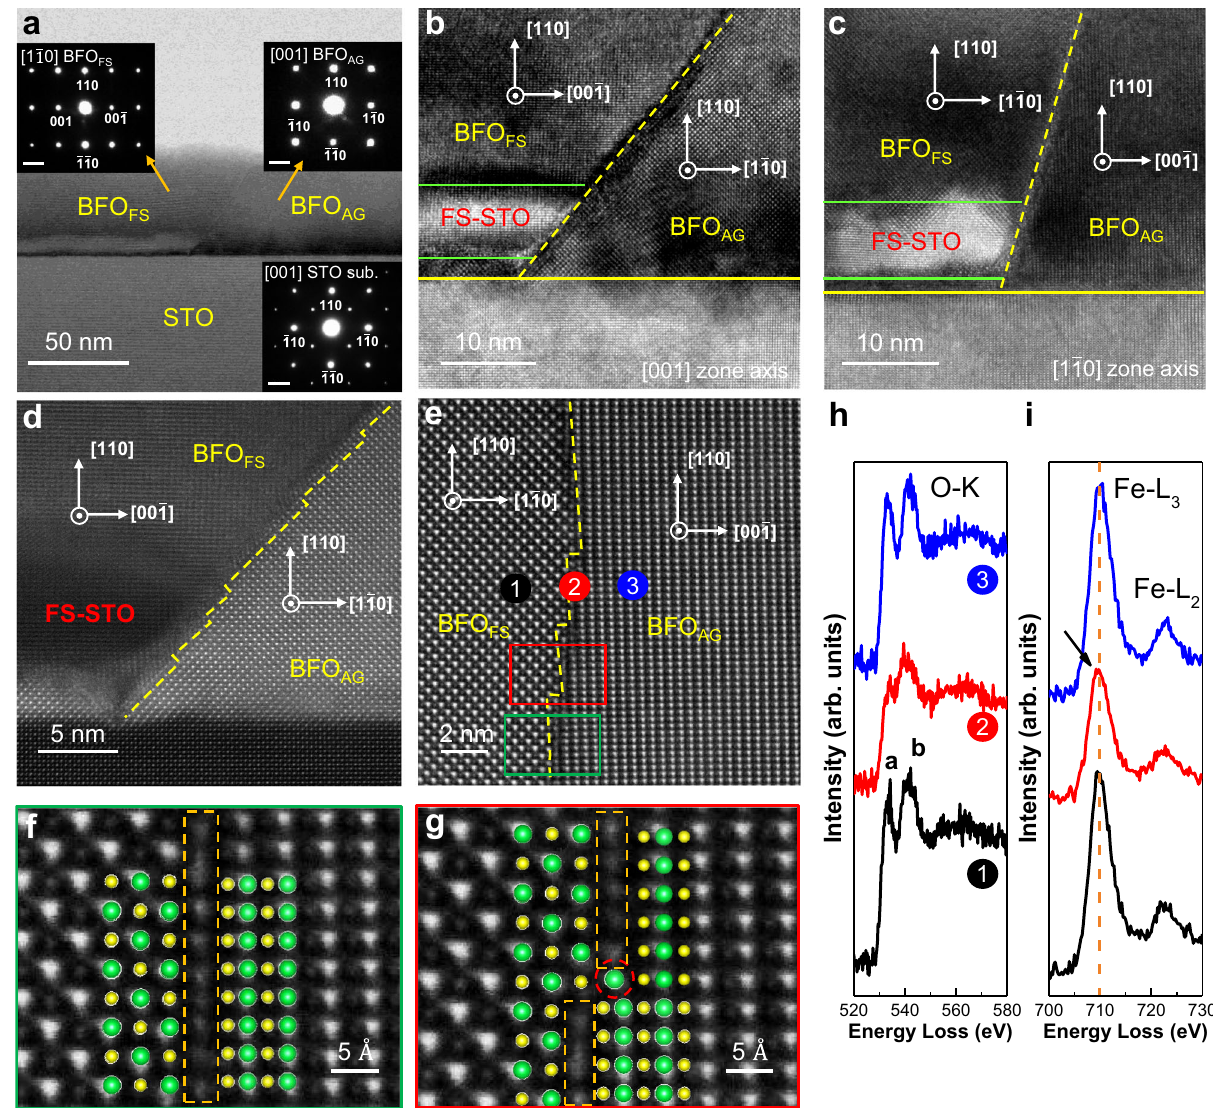
Fig. 2 Microstructure characterization of the 90° twisted BFO lateral homostructure. a Typical cross-sectional TEM image taken along [001] direction of STO substrate. The insets show the corresponding SAED patterns of STO substrate, BFO grown on pristine STO (BFO AG ), and BFO grown on FS-STO (BFO FS ), respectively, in which the scale bar refers to 2 nm − 1 . b , c HRTEM images of the interface area taken along the [001] and [1 (cid:1) 10] direction of STO substrate, respectively. d HAADF image of the interface area observed along the [001] direction of STO substrate. A gap between FS-STO and STO can be clearly seen, where the space was further fi lled with BFO. e Typical HAADF image of the BFO FS /BFO AG interface. f , g Enlarged atomic images from the green and red rectangles in ( e ). h O-K and ( i ) Fe-L 2,3 edges acquired from the region 1, 2, and 3 in ( e